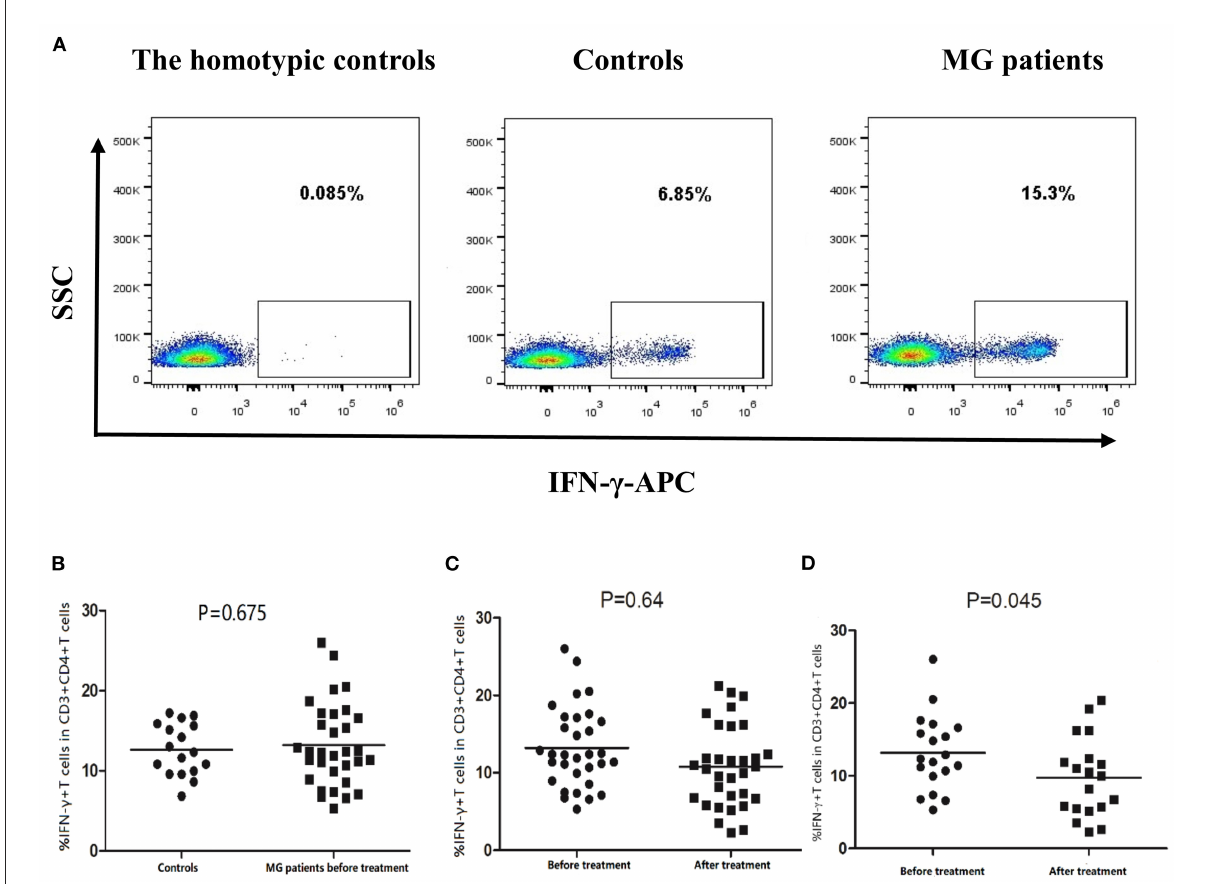
FIGURE6 Frequency of Th1 cells (CD3 + CD4 + IFN- γ + T cells) in PBMCs of controls and MG patients. (A) Gating on CD3 + CD4 + T cells, intracellular cytokine analysis of IFN- γ on PBMCs of controls and MG patients after cell culture. (B) Th1 cell frequency in controls and MG patients before treatment. (C) Th1 cell frequency in MG patients before and after treatment. (D) Th1 frequency in responsive patients before and after treatment. The horizontal bars indicate the mean. We compare MG patients and controls using unpaired t test. We compared before and after treatment using paired t